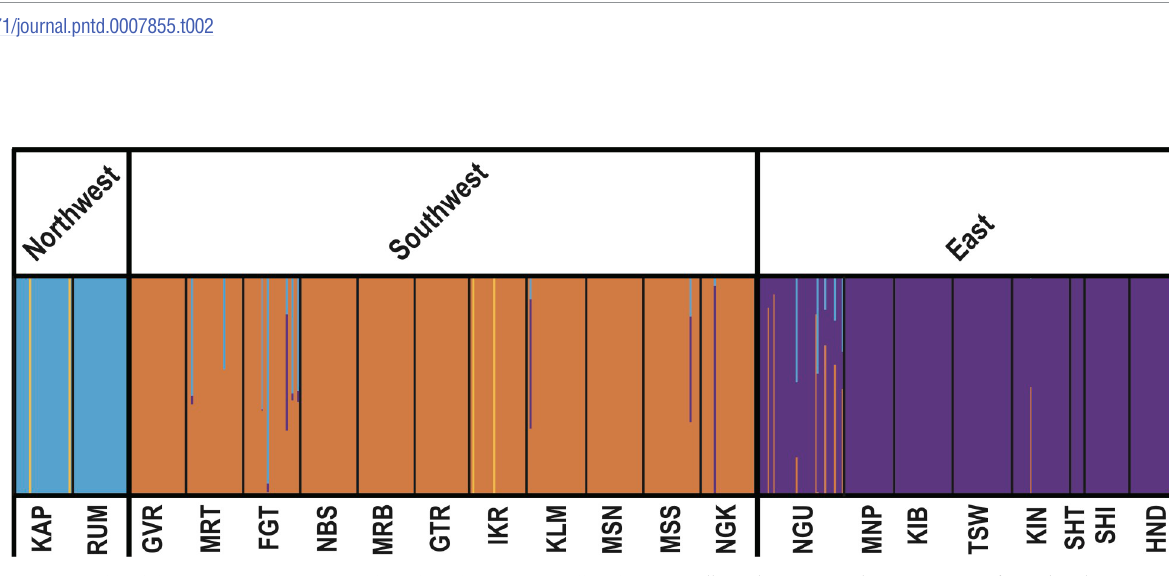
Fig 2. Results of the Bayesian clustering analyses based on microsatellite data. Spatially explicit genetic clustering was performed in the program BAPS v 6 [55,56]Vertical bars indicate the probability of assignment (q-value) of an individual to each cluster (S7 Table). Thin vertical lines separate sampling sites reported along the bottom x-axis, and think vertical lines separate the three major clusters reported along the top x-axis.